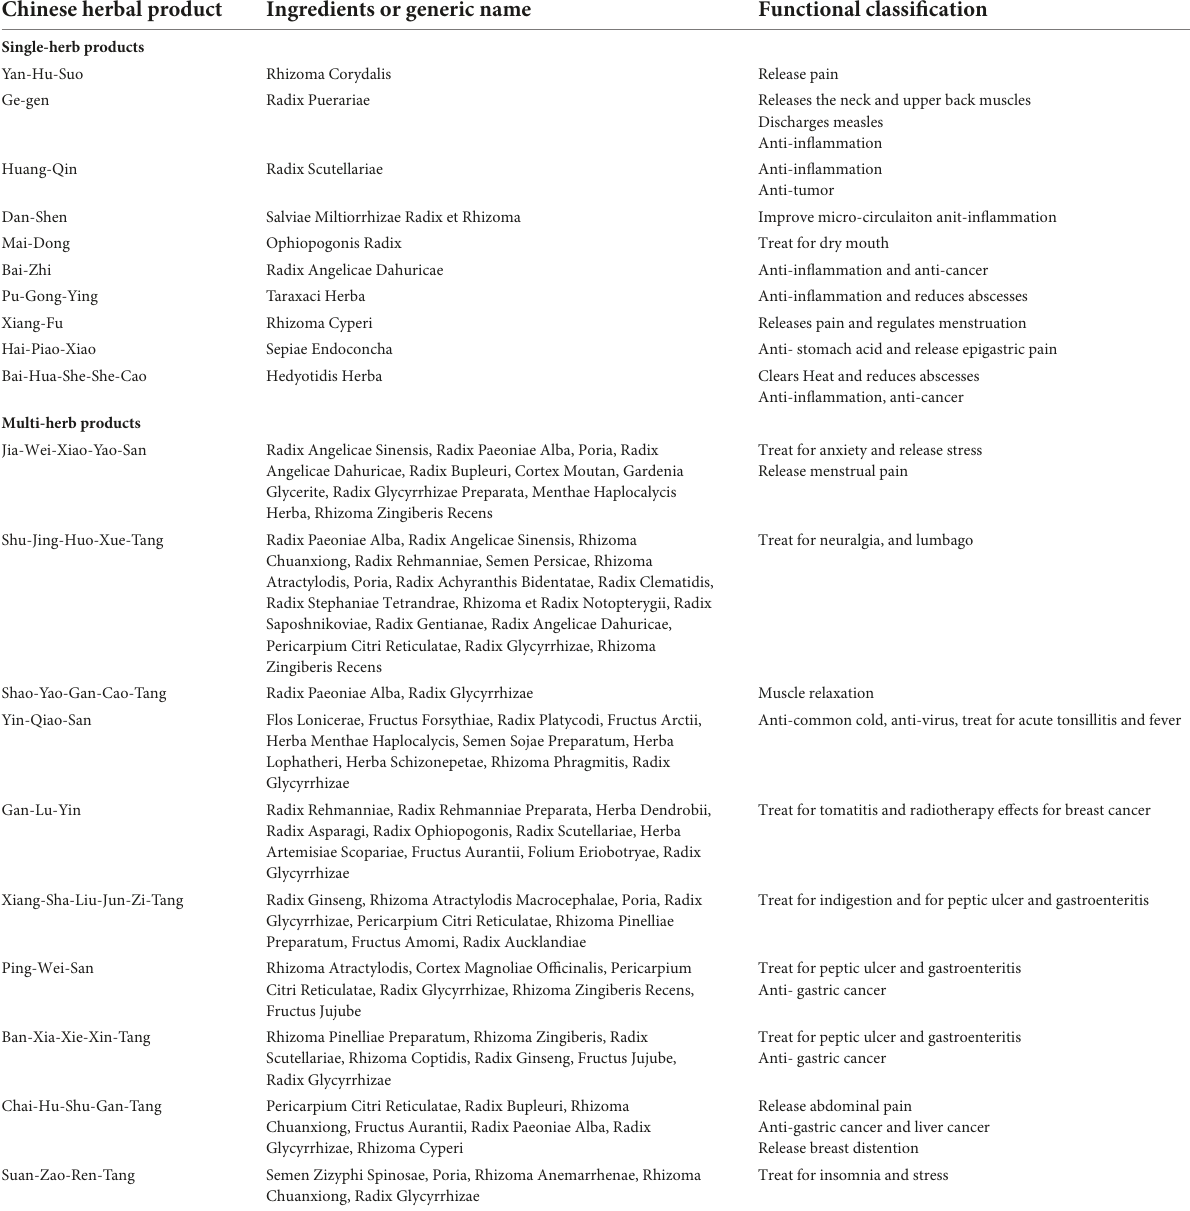
TABLE 3 Risk of depression in relation to the 10 most-used single-herb and multi-herb CHM products for participants. Chinese herbal